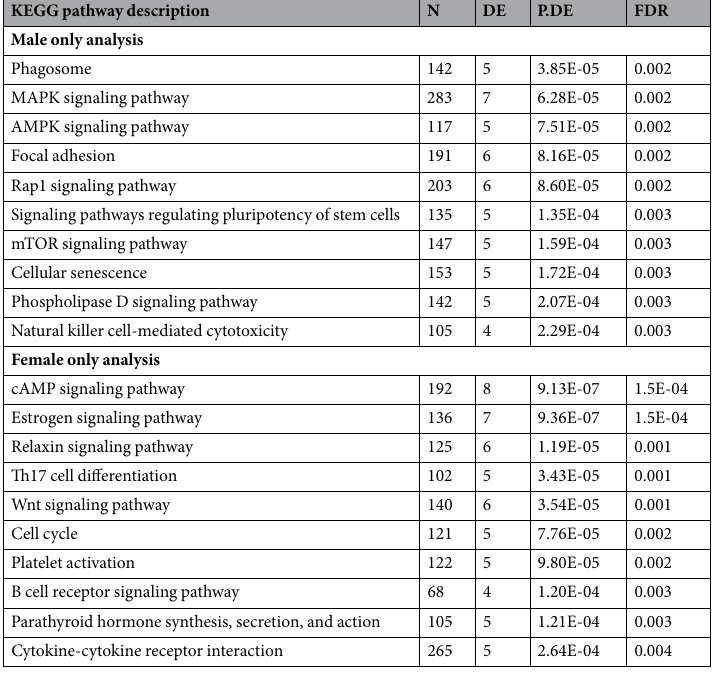
Table 5. Top 10 enriched KEGG pathways ranked by the lowest p -value associated with genes annotated to the CpGs with p < 0.0001 from the male- and female-only analyses. N, total genes in the KEGG pathway; DE, the number of genes within the CpGs with p < 0.0001; FDR, FDR-adjusted p-value for